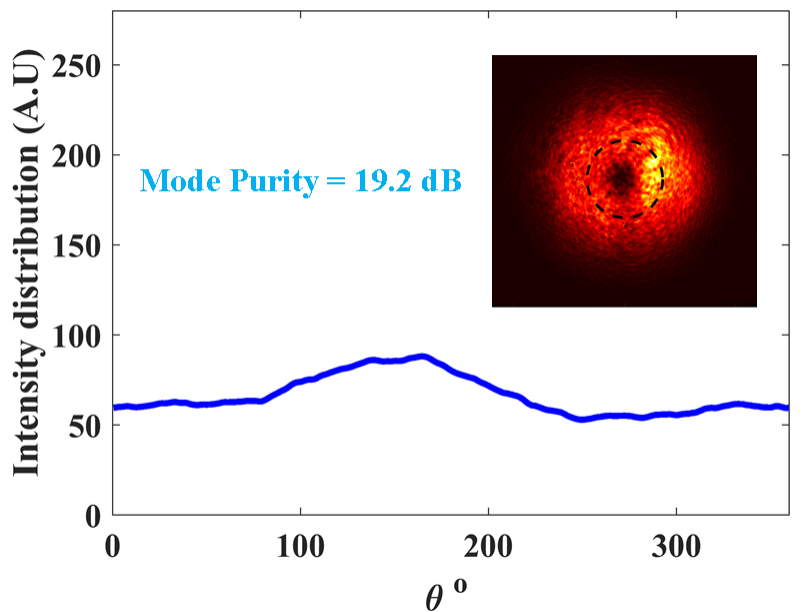
Figure A2. Azimuthal Intensity distribution of a typical vortex OAM beam at 821 nm (inset image of OAM with azimuthal ring).